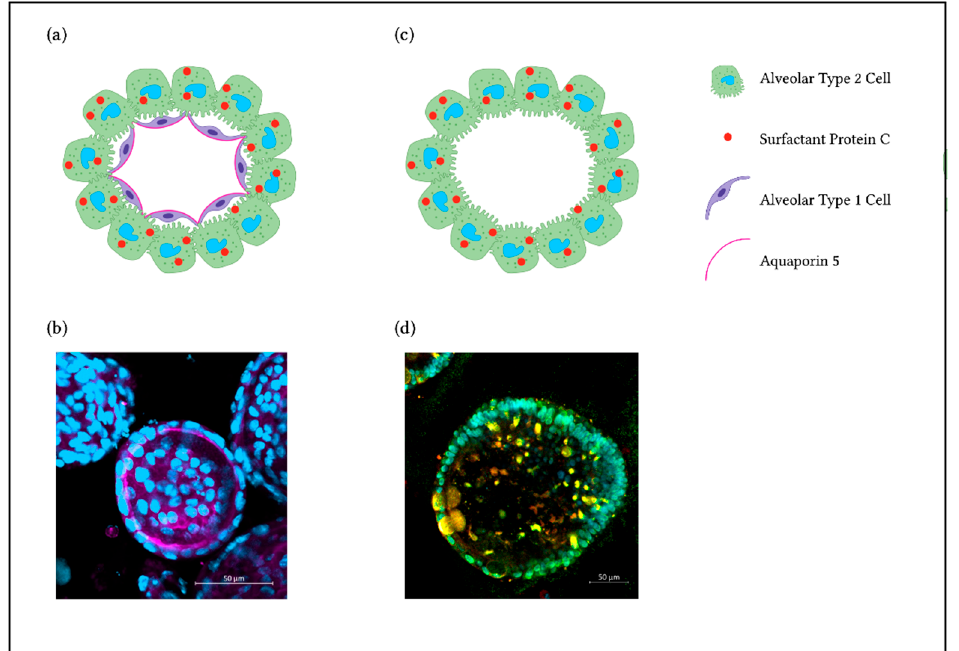
Figure 2. 3D Alveolar Organoids. ( a ) Illustration showing a primary murine alveolar organoid. ( b ) Representative immunofluorescence staining of a murine alveolar organoid showing AQP5 staining as a marker for AT1s (pink) and nuclei (DAPI, blue). ( c ) Illustration showing a hiPSC-derived alveolar organoid. ( d ) Representative immunofluorescence staining with AT2s expressing SP-C (red), NKX2.1 (green) and nuclei (DAPI, cyan).